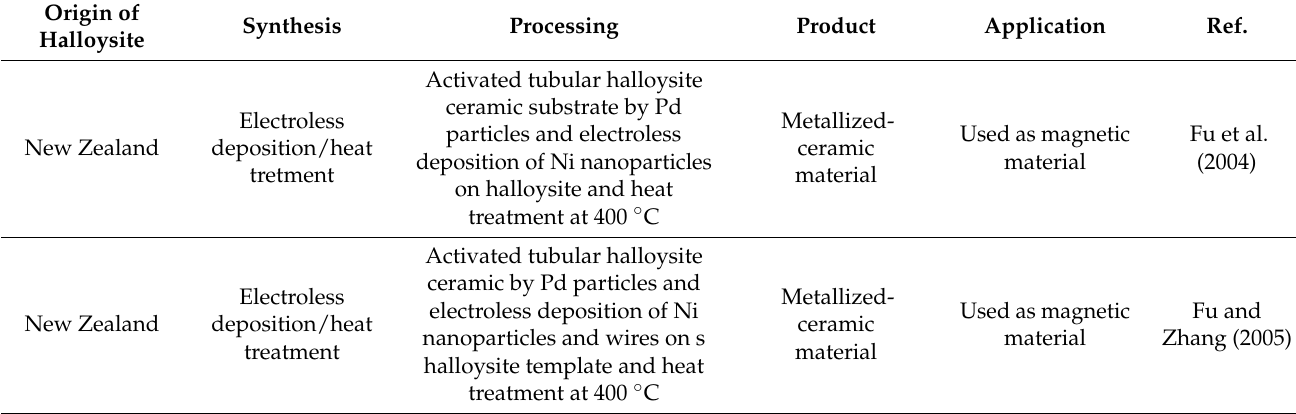
Table 3. Use of halloysite in “ceramic